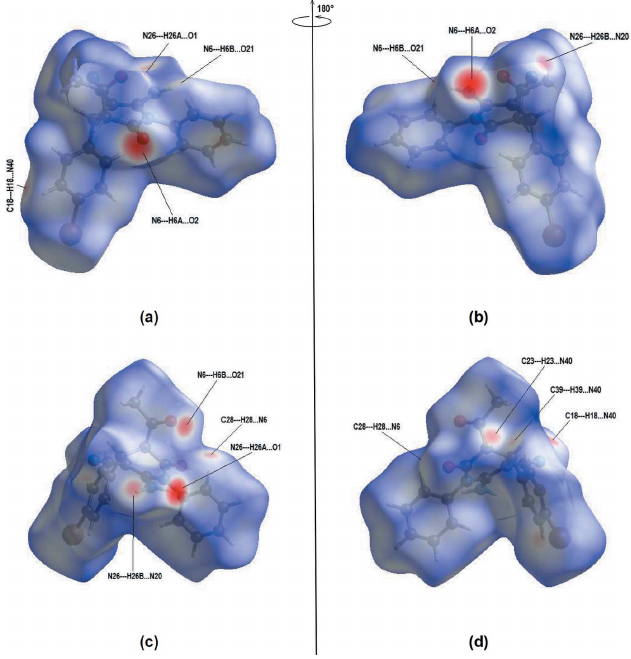
Figure 8 Front and back views of the Hirshfeld surfaces mapped over d norm for molecule A ( a , b ) and molecule B ( c , d ).